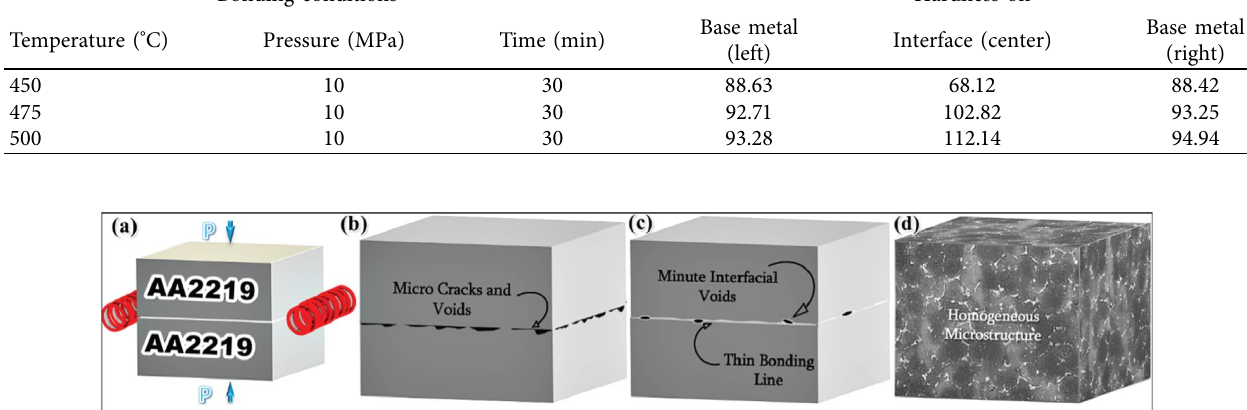
Figure 15: Microhardness behaviour across the bonded interface as a function of bonding temperature. Table 2: Infuence of bonding temperature on the hardness of bonded sections. Bonding conditions Hardness on